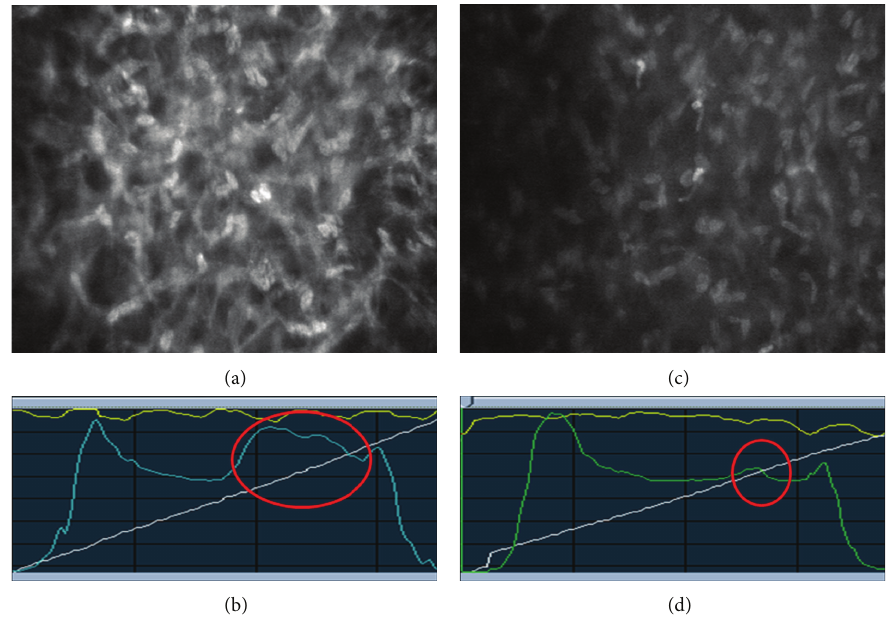
Figure 1: Fellow eyes of the same patient 1 week after surgery. (a) Activated keratocytes (at 150 𝜇 m depth) organized as a network after SMILE surgery. (b) Anterior stroma of the same eye shows dramatically increased corneal backscatter (circle). (c) Keratocytes (at 150 𝜇 m depth) in the fellow eye that underwent femto-LASIK surgery. (d) After femto-LASIK surgery, there is a limited increase in corneal backscatter compared with SMILE